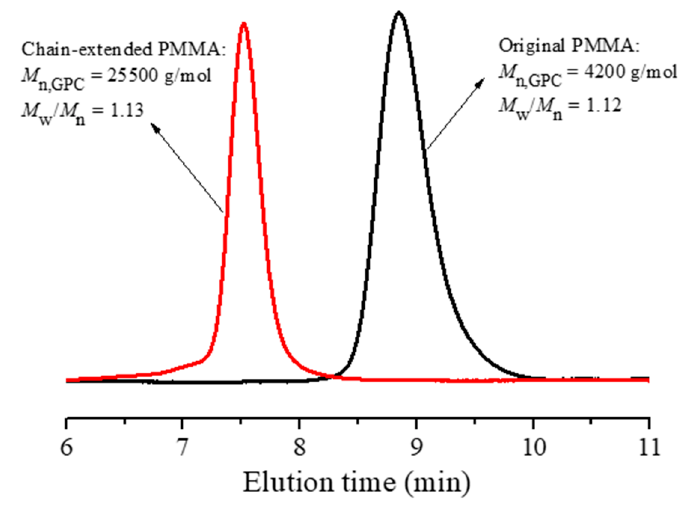
Figure 4. Gel Permeation Chromatography (GPC) curves before and after chain extension using PMMA as the macroinitiator via AGET ATRP with thiol-functional cell paper as reducing agent. Polymerization conditions: original PMMA: [MMA] 0 /[EBPA] 0 /[CuBr 2 ] 0 /[PMDETA] 0 = 400/4/0.25/0.5, m (Cell-SH) = 50 mg, V MMA = 2.0 mL, V anisole = 1.0 mL, Temperature = 90 °C, time = 1.5 h. Chain-extended PMMA: [MMA] 0 /[PMMA-Br] 0 /[CuBr 2 ] 0 /[PMDETA] 0 = 400/2/0.25/0.5, m (Cell-SH) = 50 mg, V MMA = 1.6 mL, V anisole = 1.0 mL, Temperature = 90 °C, time = 2.5 h.